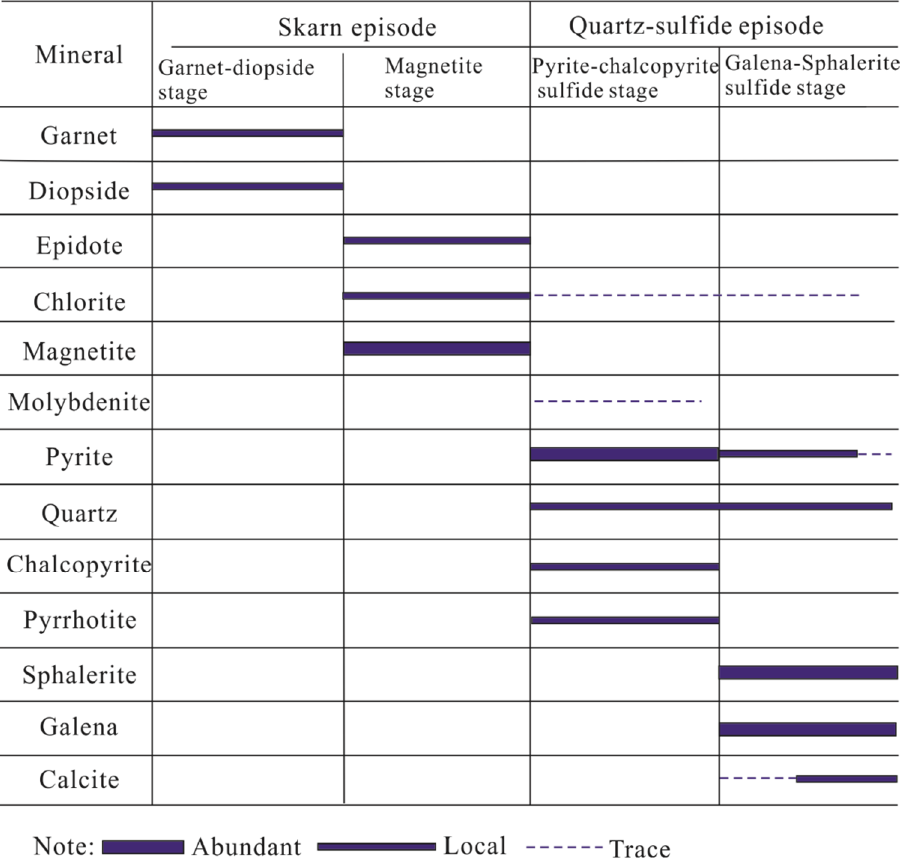
Figure 5. Paragenetic sequence of ore and gangue minerals in the Fe-Cu ore body of the Shuikoushan deposit.